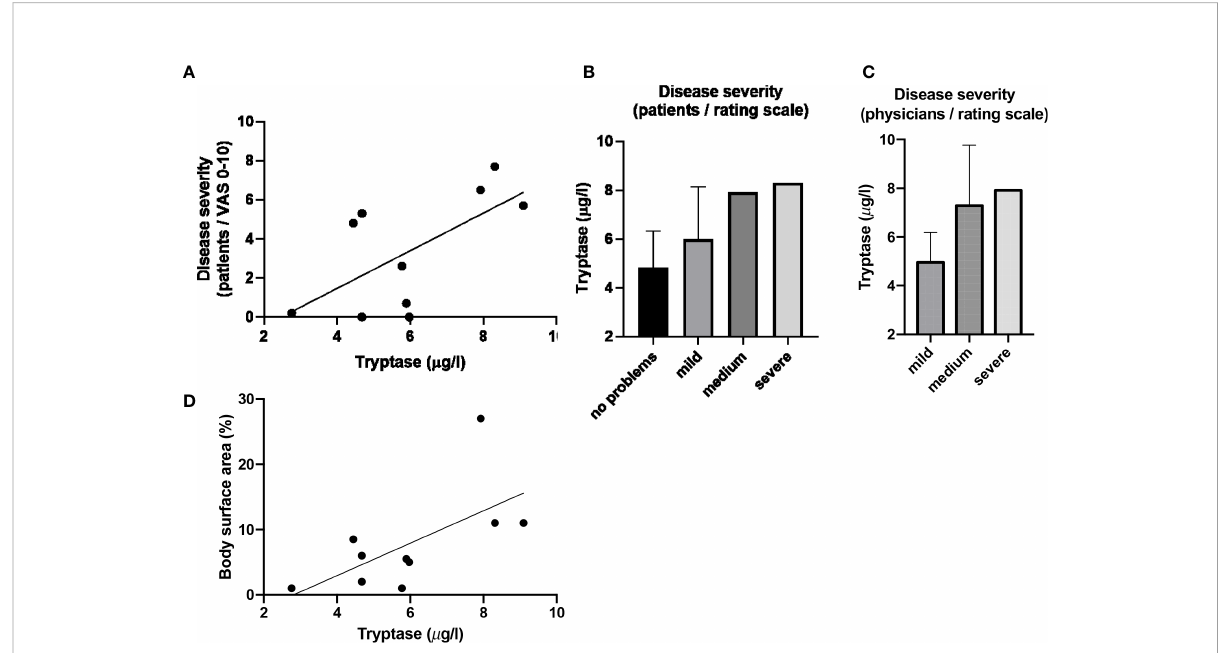
FIGURE 2 Blood tryptase counts correlate with disease severity and affected body surface area. (A) Serum Tryptase levels plottet against severity evaluated by patients using VAS (including depiction of linear correlation). (B) Tryptase versus disease severity evaluated by patients using rating scale (values given as mean and SD). (C) Tryptase versus disease severity evaluated by physicians using rating scale (values given as mean and SD). (D) Serum Tryptase levels plotted against affected body surface area (including depiction of linear